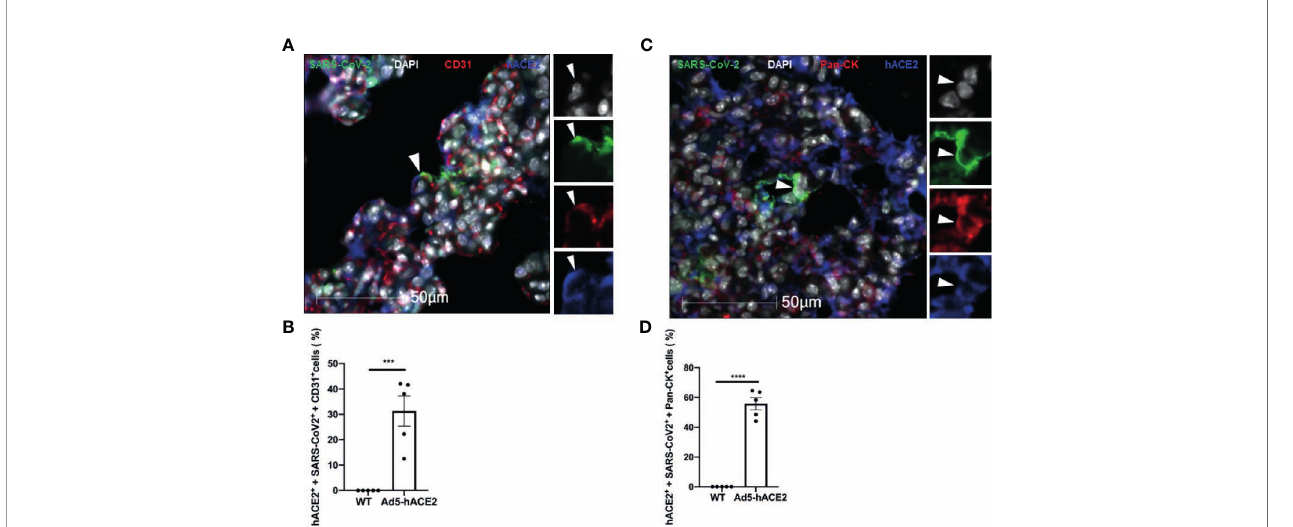
FIGURE 6 | Endothelial cell infection occurs with the presence of hACE2 inthe SARS-CoV-2 infectedAd5-hACE2 mice. (A) Representative image shows co-localization (arrowhead) of SARS-CoV-2 proteins (green) with hACE2 (blue) andCD31 (red)in the lungs of infected Ad5-hACE2 mice at 3 DPI (n= 5). (B) The ratioofinfected hACE2 + endothelial cells (hACE2 + , SARS-CoV-2 + andCD31 + ) to total infected cells. (C) Representative image shows co-localization (arrowhead)ofSARS-CoV-2 proteins (green) with hACE2 (blue) and Pan-CK (red) in the lungs of infected Ad5-hACE2 mice at 3 DPI (n= 5). (D) The ratioof the infected hACE2 + pneumocytes (hACE2 + , SARS-CoV-2 + andPan-CK + ) to total infected cells. Multilabel immuno fl uorescence histochemistrywas used to quantify the proportion of SARS-CoV-2 positive cellsexpressing the markers PanCK and CD31 with or without ACE2, in the infected Ad5-hACE2 micelungat3DPI (Mean ± SEM, n = 5, quantitative analysiswas performed from96 and106 microscopic regionsfrom 5 fl uorescent immunohistrochemsitry staining slides ofthe 5 infectedAd5-hACE2 mice respectively (1slideper mouse).WT: SARS-CoV-2-infected B6 wild type mice; and Ad5-hACE2: SARS-CoV-2-infectedAd5-hACE2 mice. ***P < 0.001 vs WT, and****P < 0.0001 vs